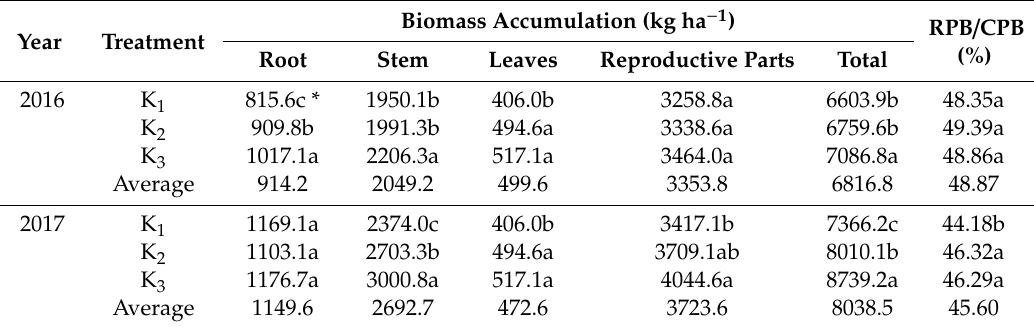
Table 2. Cotton and each part biomass accumulation influenced by K fertilizer amounts.